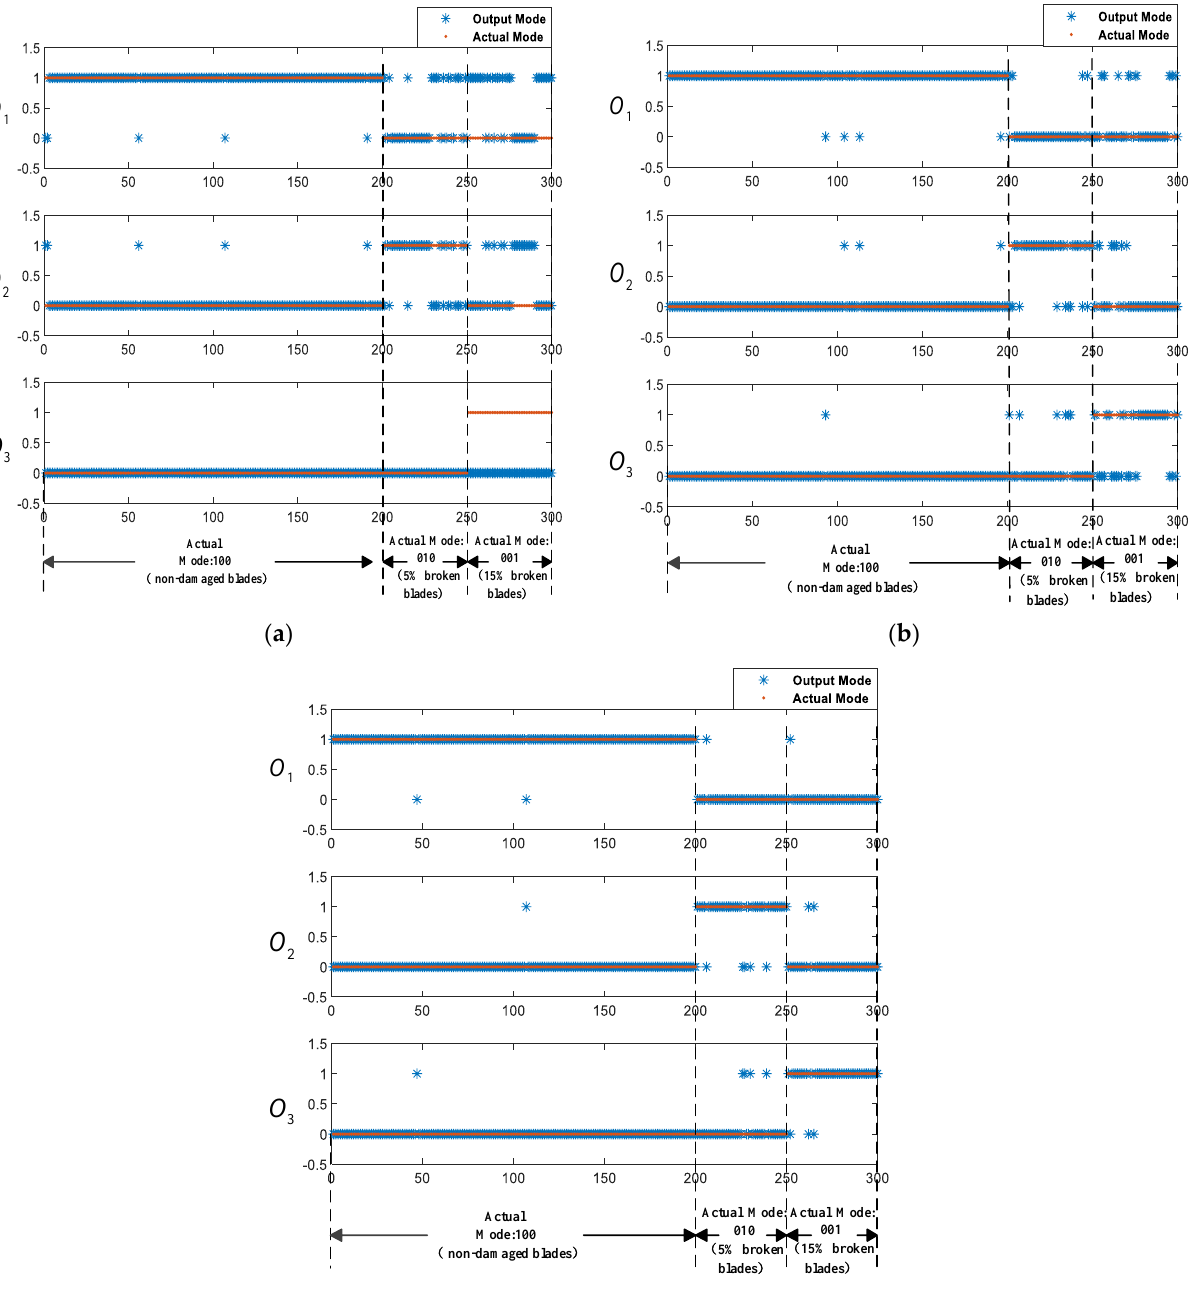
Figure 8. The output results of the three methods: ( a ) FDI results of method 1, ( b ) FDI results of method 2, ( c ) FDI results of method 3.